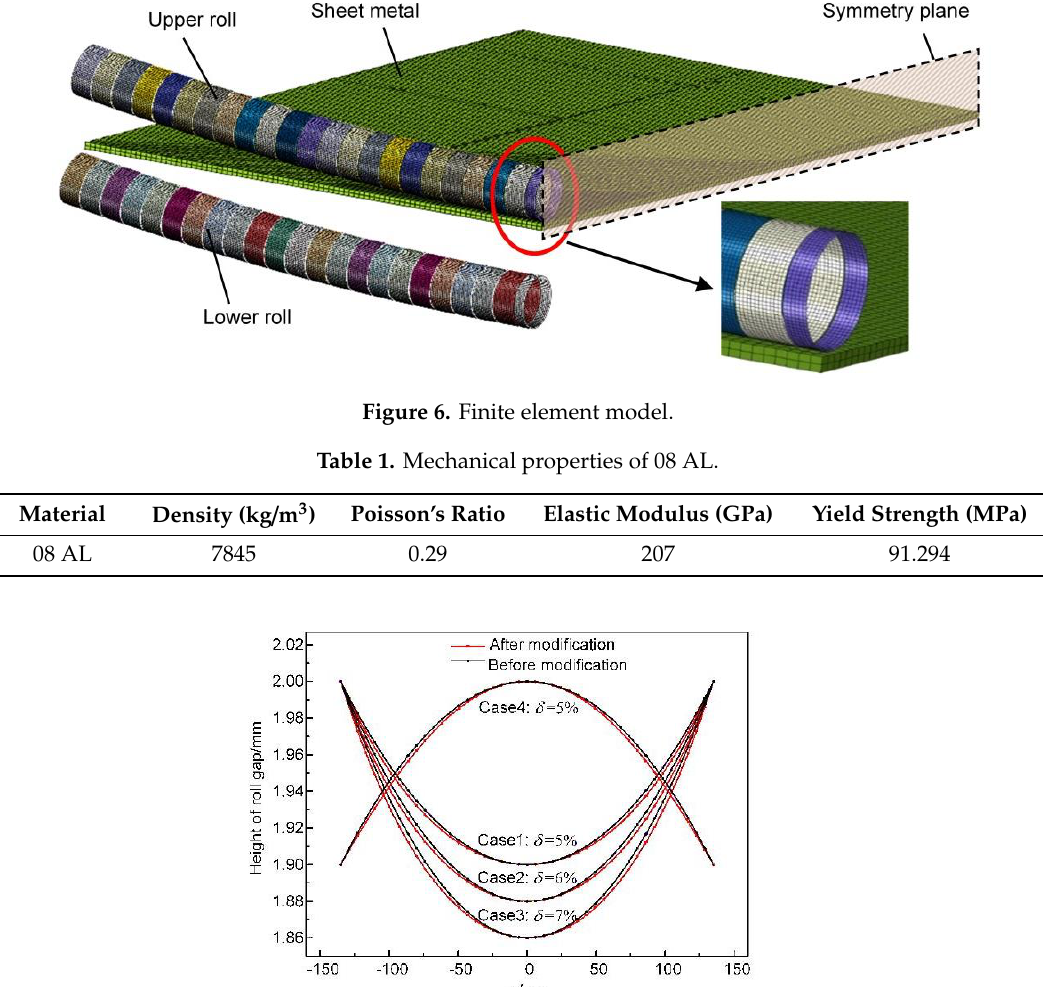
Figure 6. Finite element model.